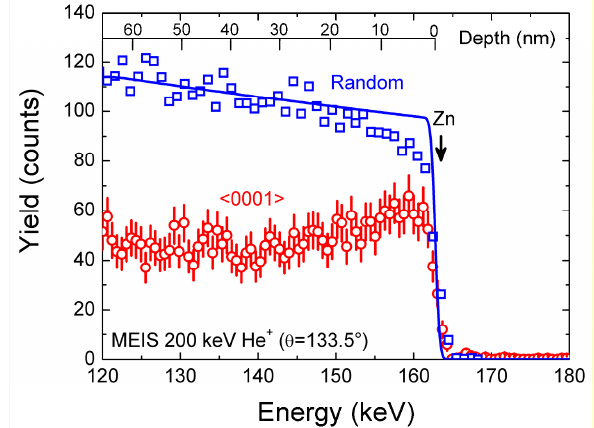
Figure 4. Random and aligned medium energy ion scattering (MEIS) spectra of the ZnO sample irradiated at the highest fluence (2 × 10 18 cm − 2 ). The solid line shows the fit for the random spectrum.